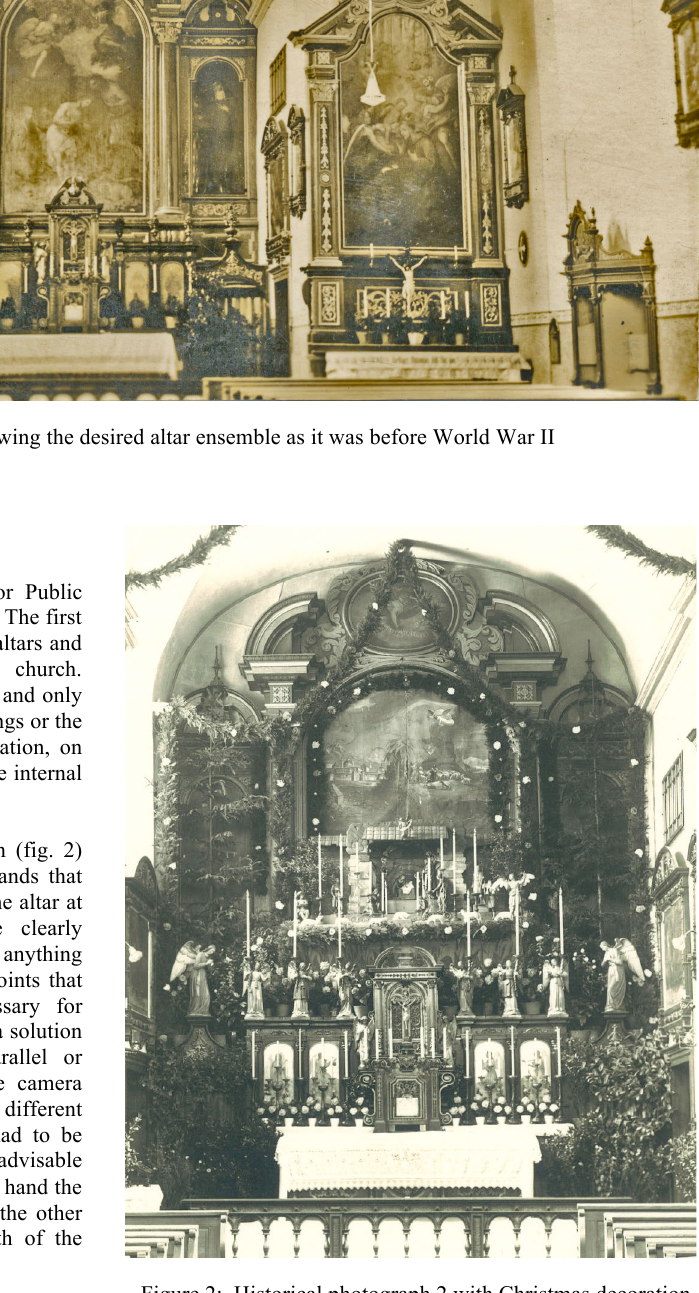
Figure 2: Historical photograph 2 with Christmas